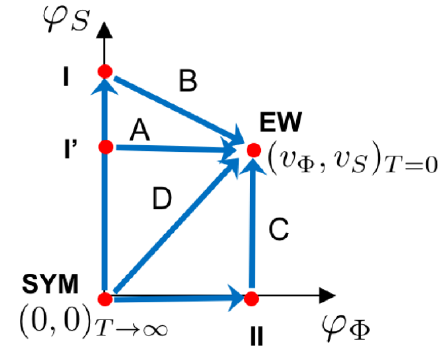
Figure 1 . Four types of PT path are labeled by A, B, C and D. Here, SYM and EW denotes the symmetric phase ( ϕ , ϕ S ) = (0 , 0) T →∞ , and the EW phase ( v Φ denoted by I (0 , ϕ S > v S ), I’ (0 , v S ) and II ( v Φ , 0). For details, see refs. [45, 46, 48,